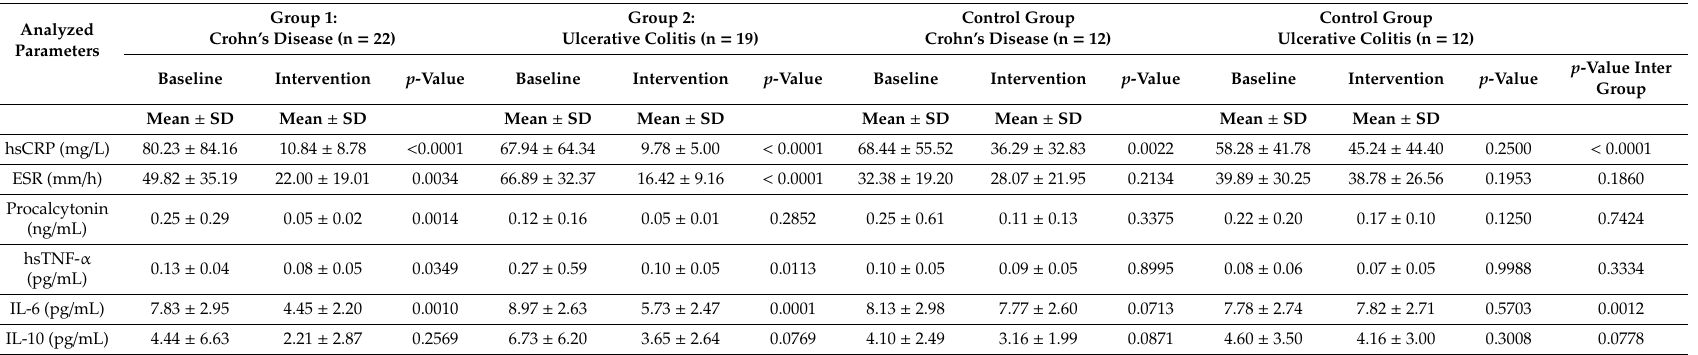
Table 5. The changes during the combined enteral and parenteral nutrition in selected inflammatory parameters in IBD patients (n = 65). Analyzed